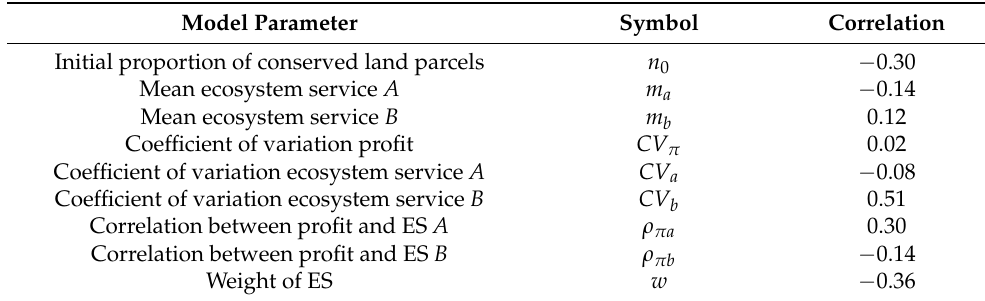
Table 5. Pearson correlation coefficients between model parameter and the loss ∆ A averted when the trading rule is changed from Equations